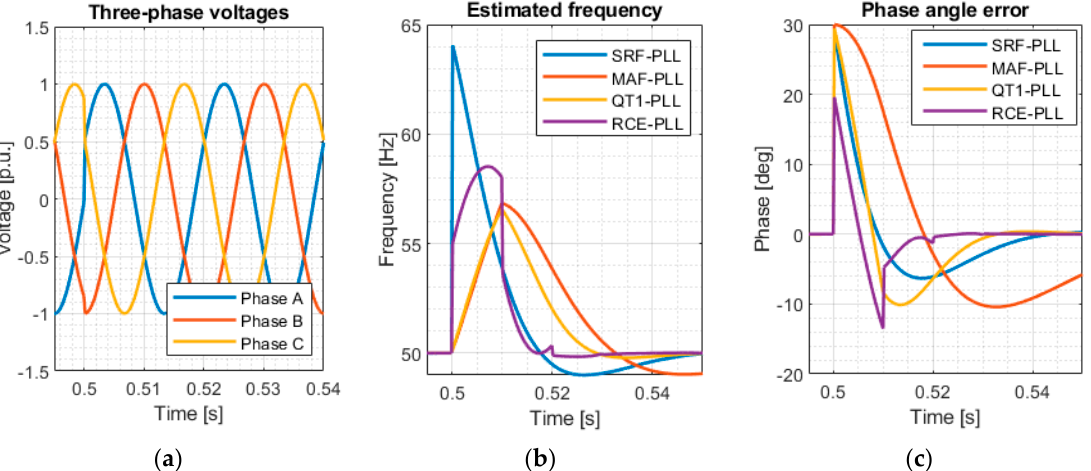
Figure 11. The +30° phase jump test. ( a ) Grid voltage waveforms; ( b ) estimated grid frequency; ( c ) phase angle error.